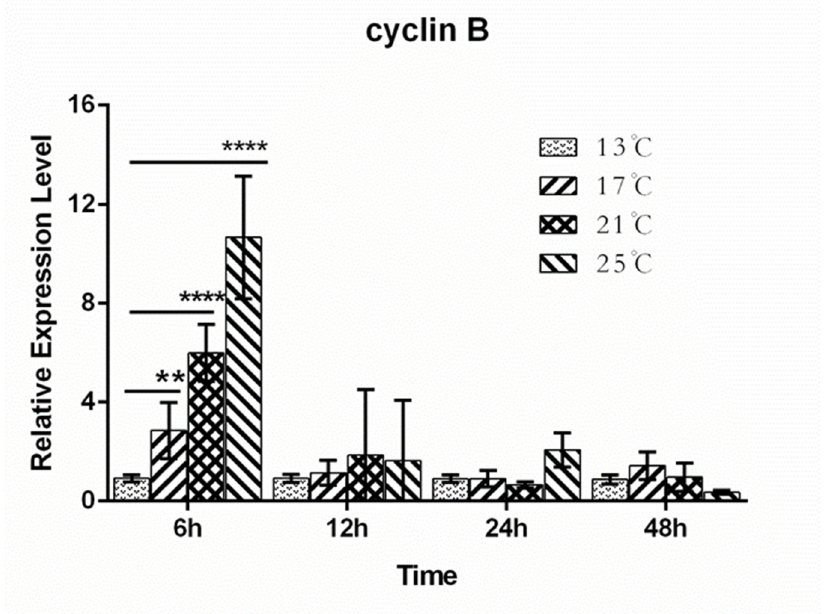
Figure 7. The relative expression level of Cyclin B in N. yezoensis incubated at different temperatures. Data represent mean ± standard errors ( n = 3). ** p < 0.01, **** p < 0.0001, vs. 13 °C.